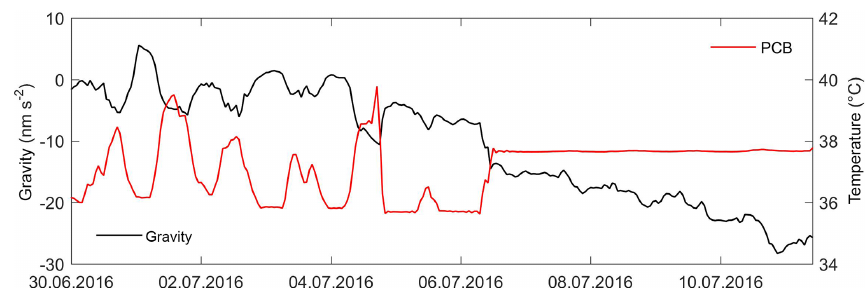
Figure 4. Comparison of gravity residuals and PCB (electronics board) temperature before and after improvement of temperature control inside the field enclosure on 7 July 2016. Note that there is an offset of about 4 ◦ C between the PCB set point temperature (34 ◦ C) and the actual recorded